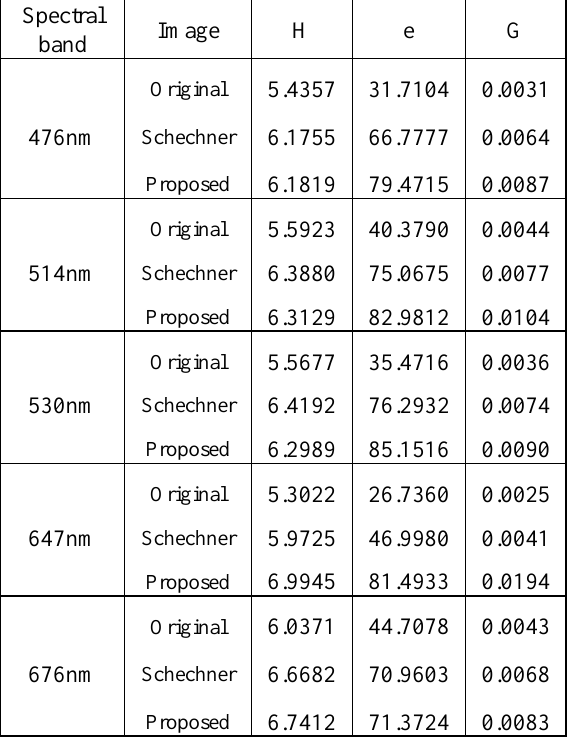
Table 2. Quantitative comparison of the 5 spectral bands for image quality evaluation indexes.